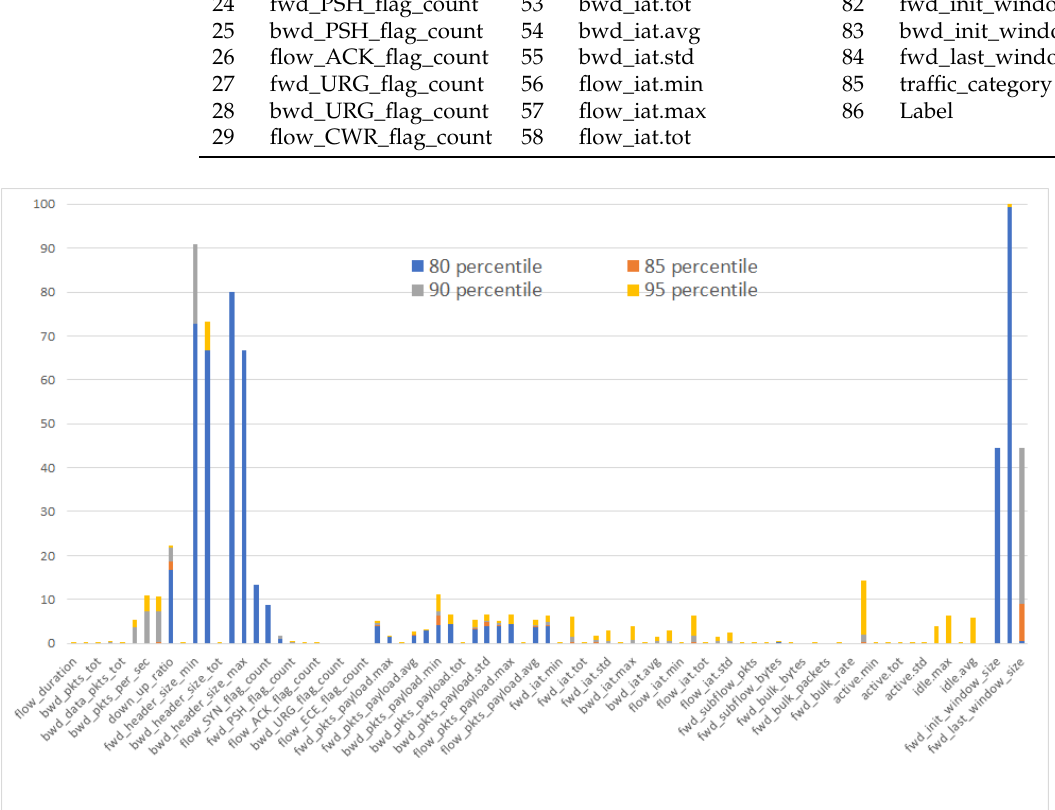
Figure 4. Most of the features are skewed, where the value of the 95th percentile is less than ten percent of the maximum